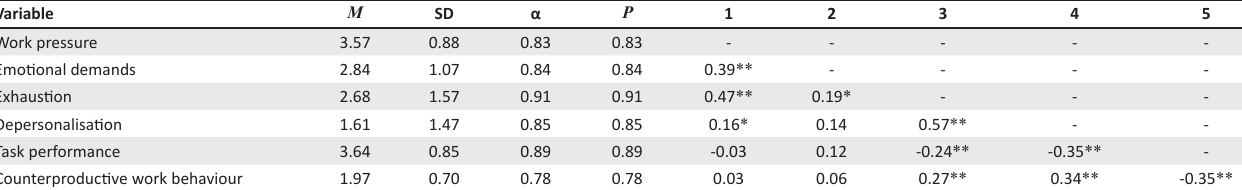
TABLE 3: Correlation matrix including reliabilities means and standard deviations. Variable